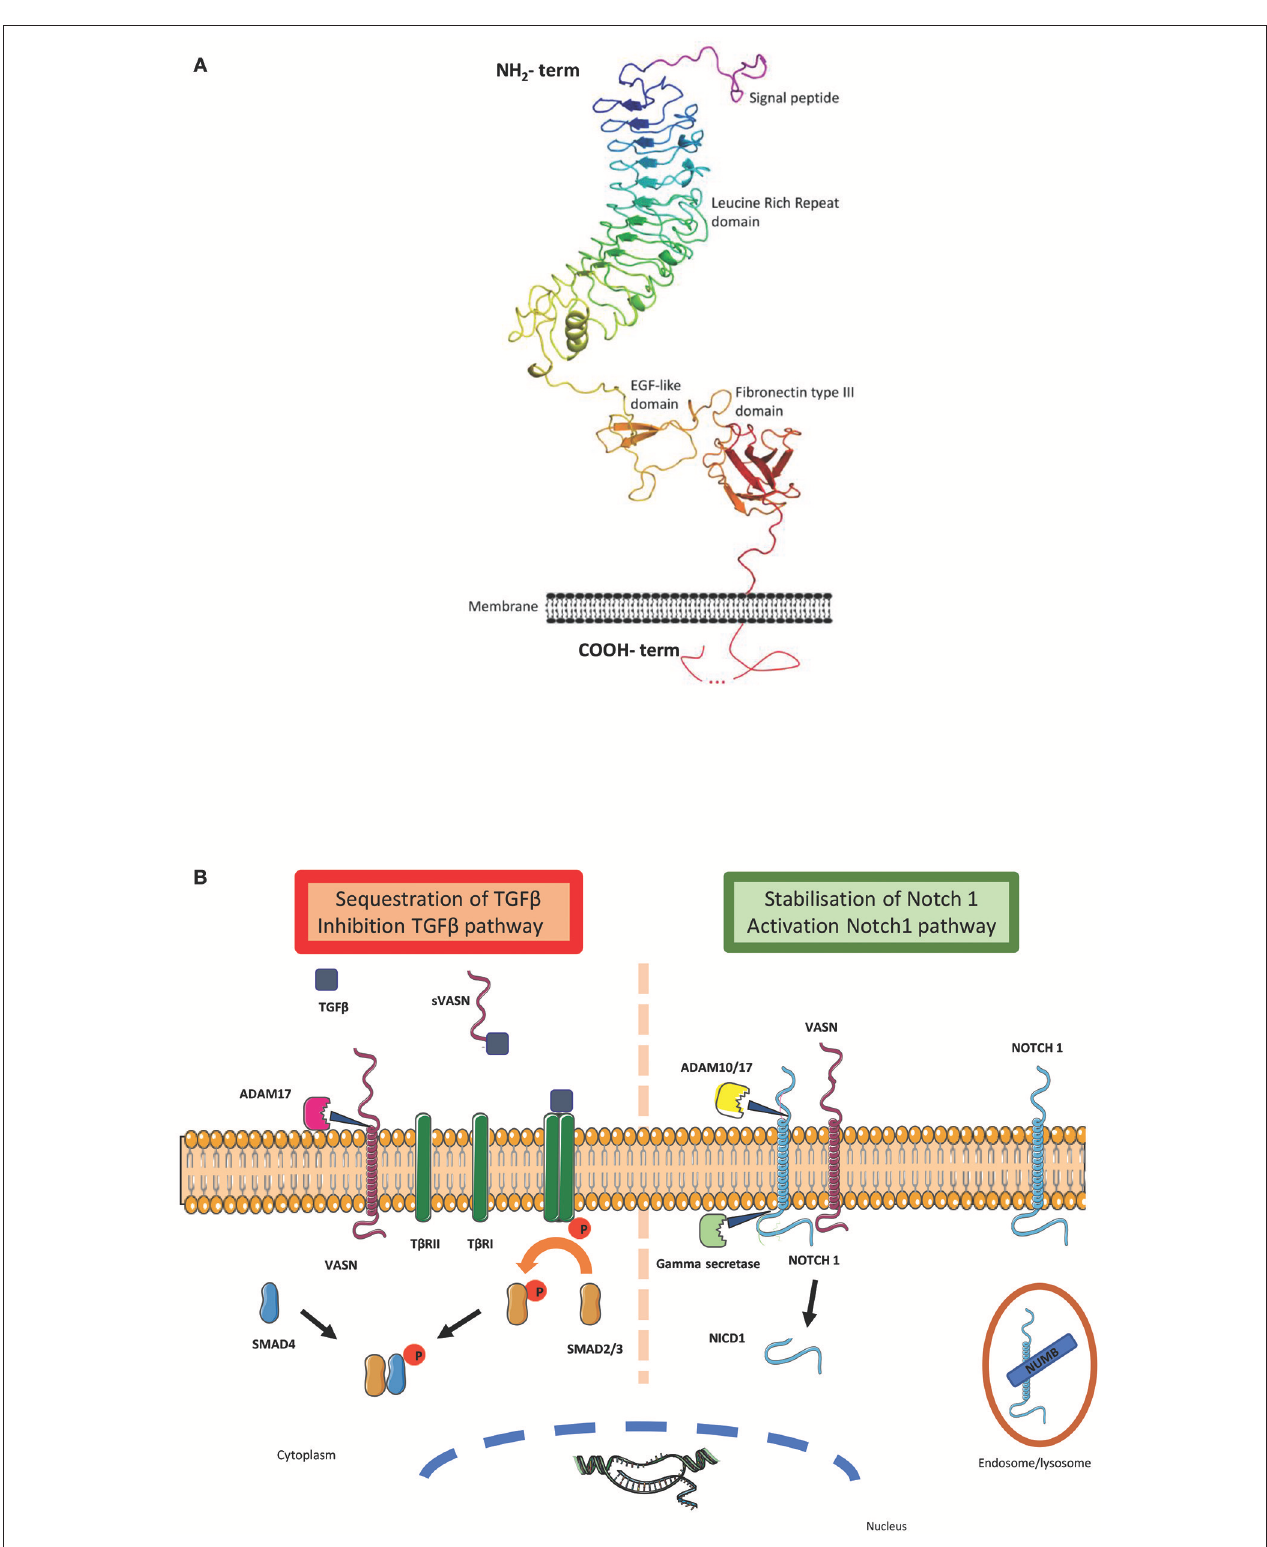
FIGURE 1 | (A) Vasorin 3D structure: Cartoon representation of the structure model of Vasn predicted by RaptorX (http://raptorx.uchicago.edu/). It is represented in rainbow color from the N-terminus to the C-terminus, at the exception of the predicted signal peptide (http://www.cbs.dtu.dk/services/SignalP/) colored in purple. The